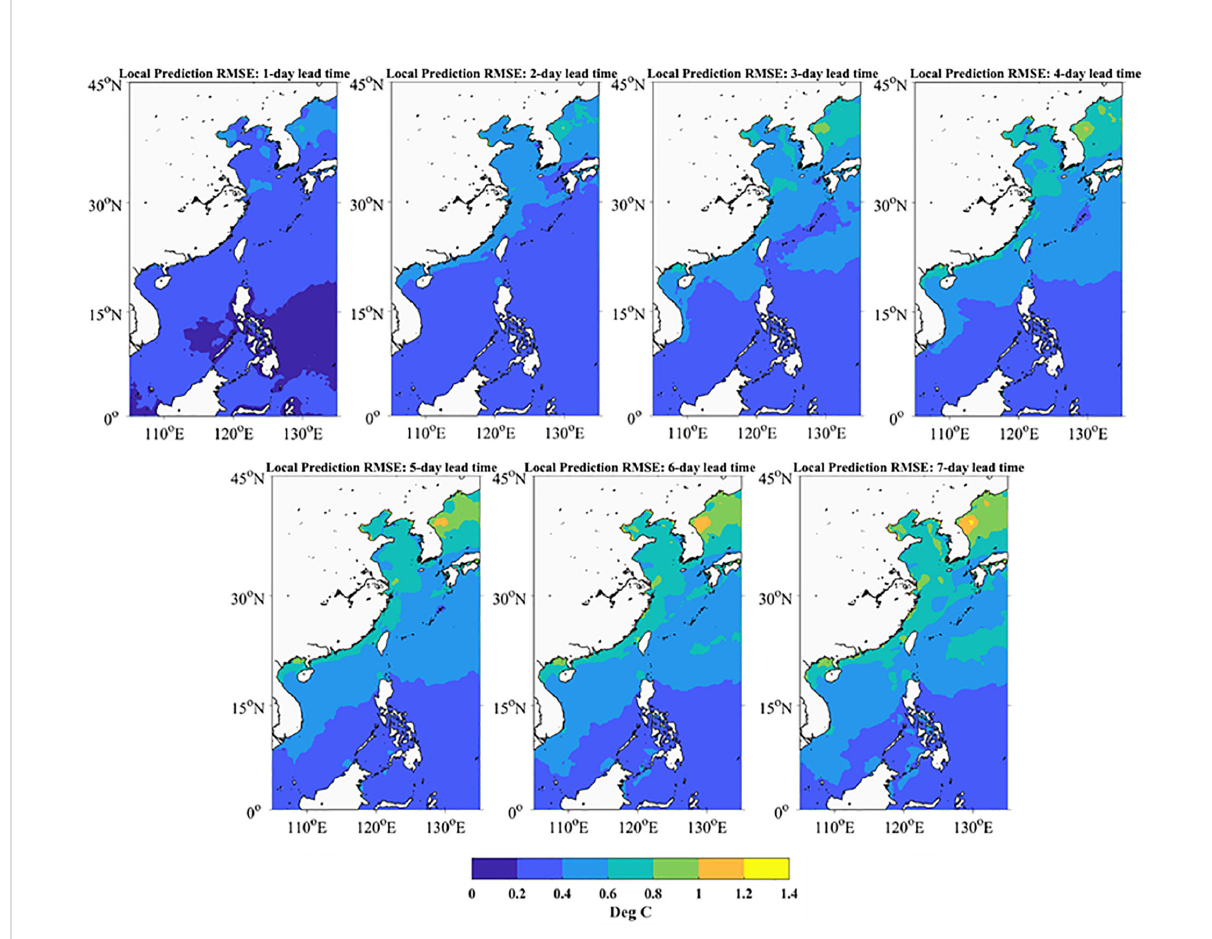
FIGURE 3 The spatial distribution of the RMSE between predicted SSTs of the 3DConv-LSTM and OSTIA during 2015-2019 at a 1- to 7-day lead